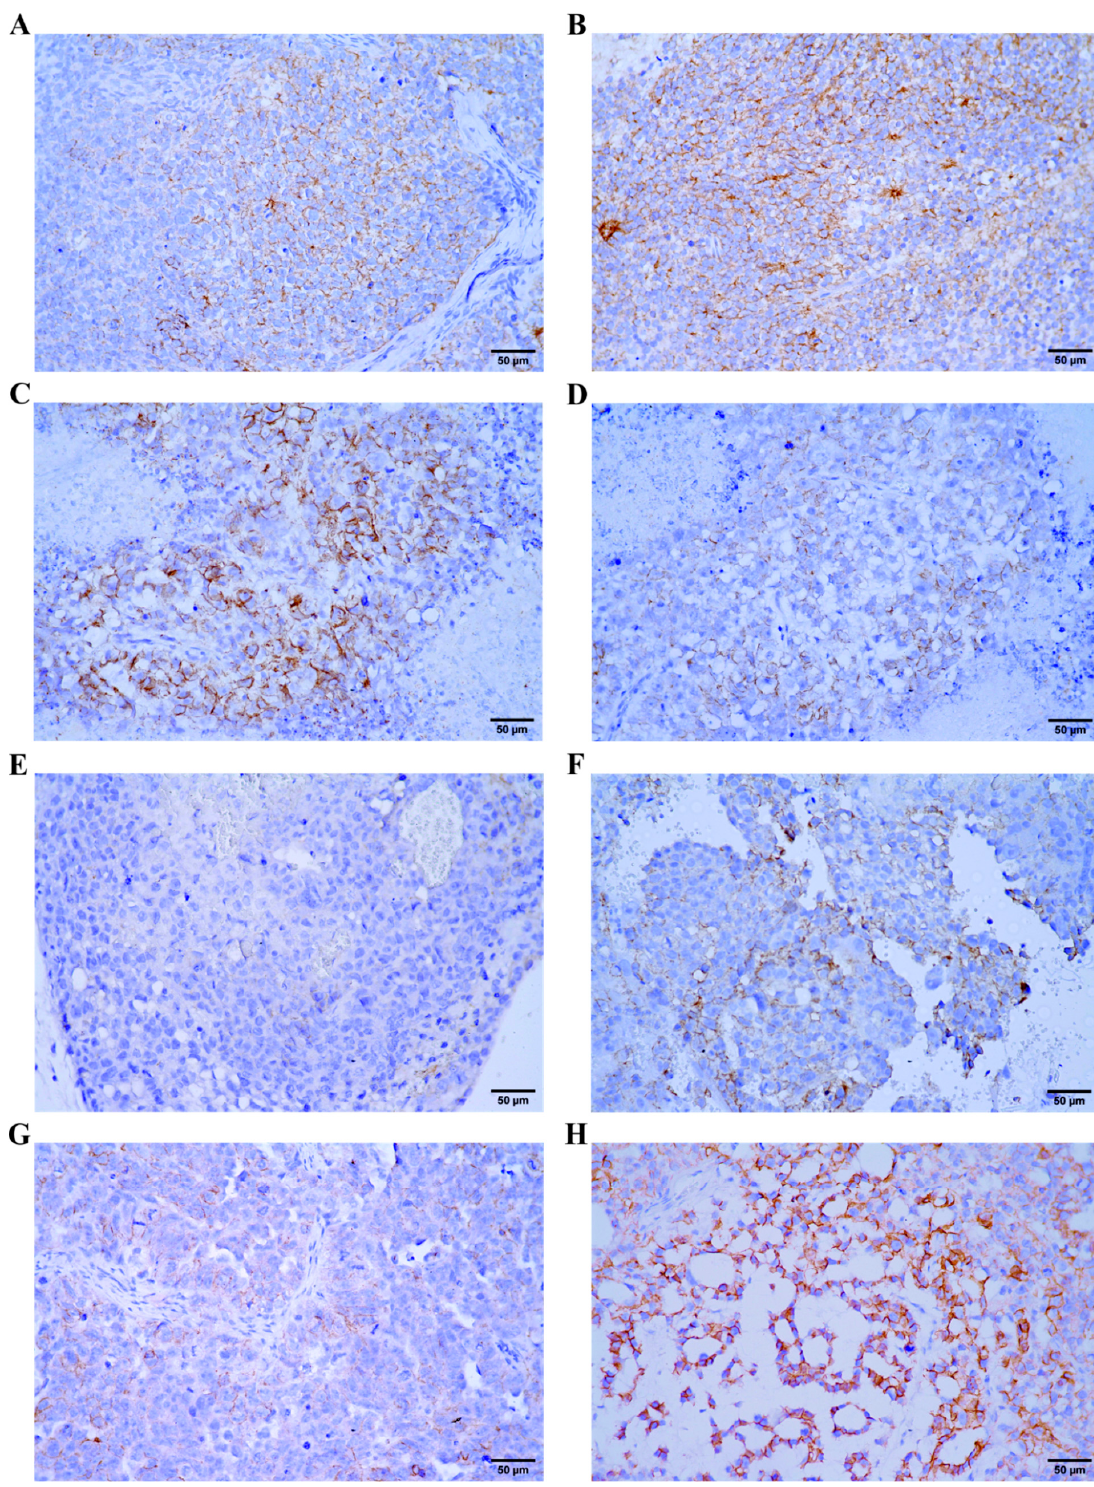
Figure 3. Immunohistochemical expression of β -catenin in GCT cell line xenografts. ( A ) NTERA-2, focal moderate membranous positivity (brown color) of tumor cells. ( B ) NTERA-2 CisR, strong membranous positivity (brown color) of tumor cells. ( C ) NCCIT, strong membranous positivity (brown color) of tumor cells. ( D ) NCCIT CisR, weak membranous positivity (brown color) of tumor cells. ( E ) JEG-3, negative (blue color) tumor cells. ( F ) JEG-3 CisR, moderate membranous positivity (brown color) of tumor cells. ( G ) TCam-2, weak membranous positivity (brown color) of tumor cells. ( H ) TCam-2 CisR, strong membranous positivity (brown color) of tumor cells. Original magnification ×